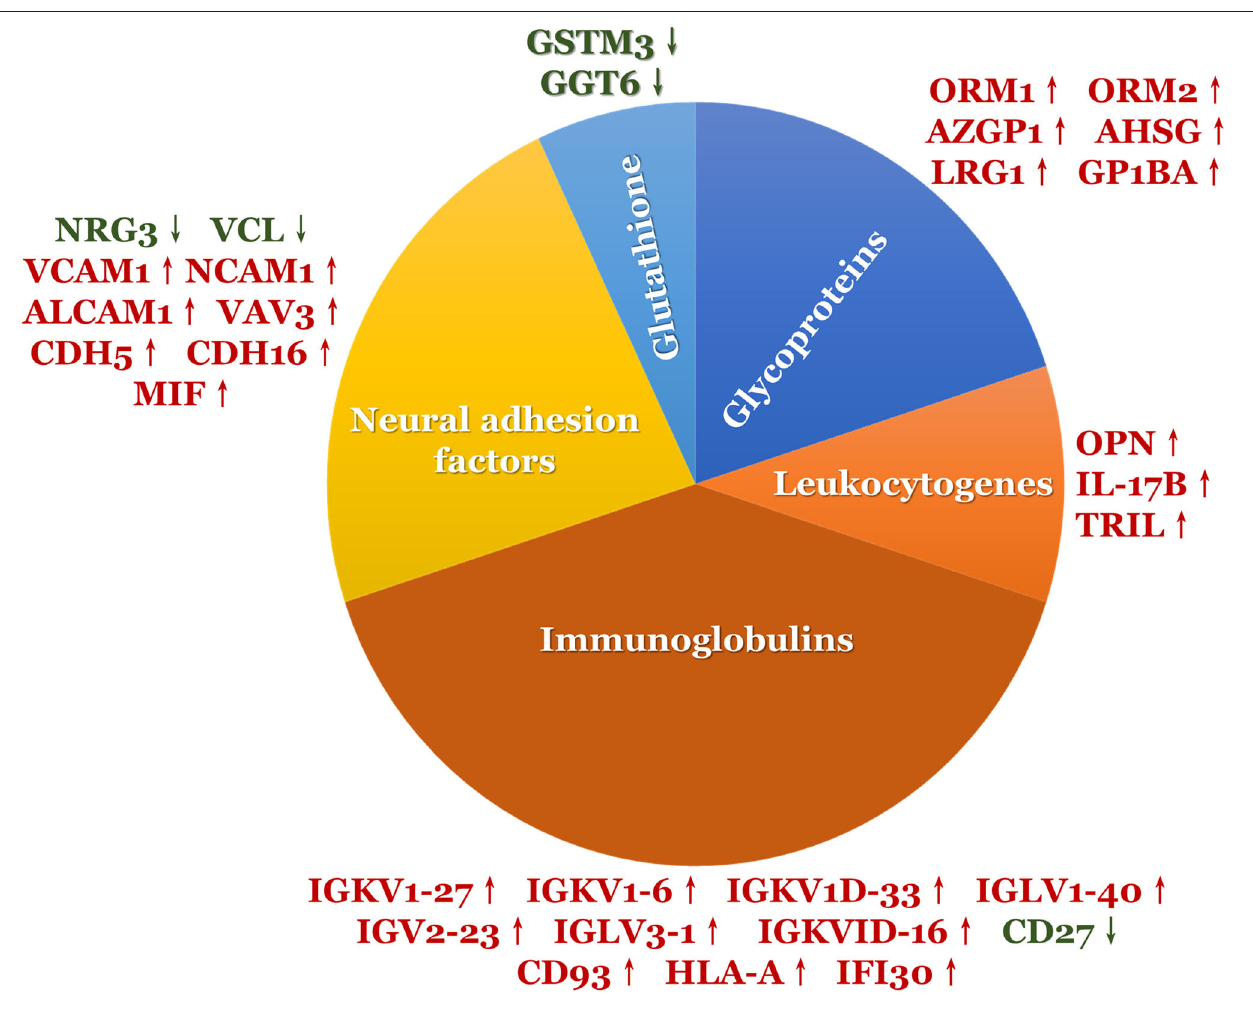
FIGURE 1 | The DEPs involved in